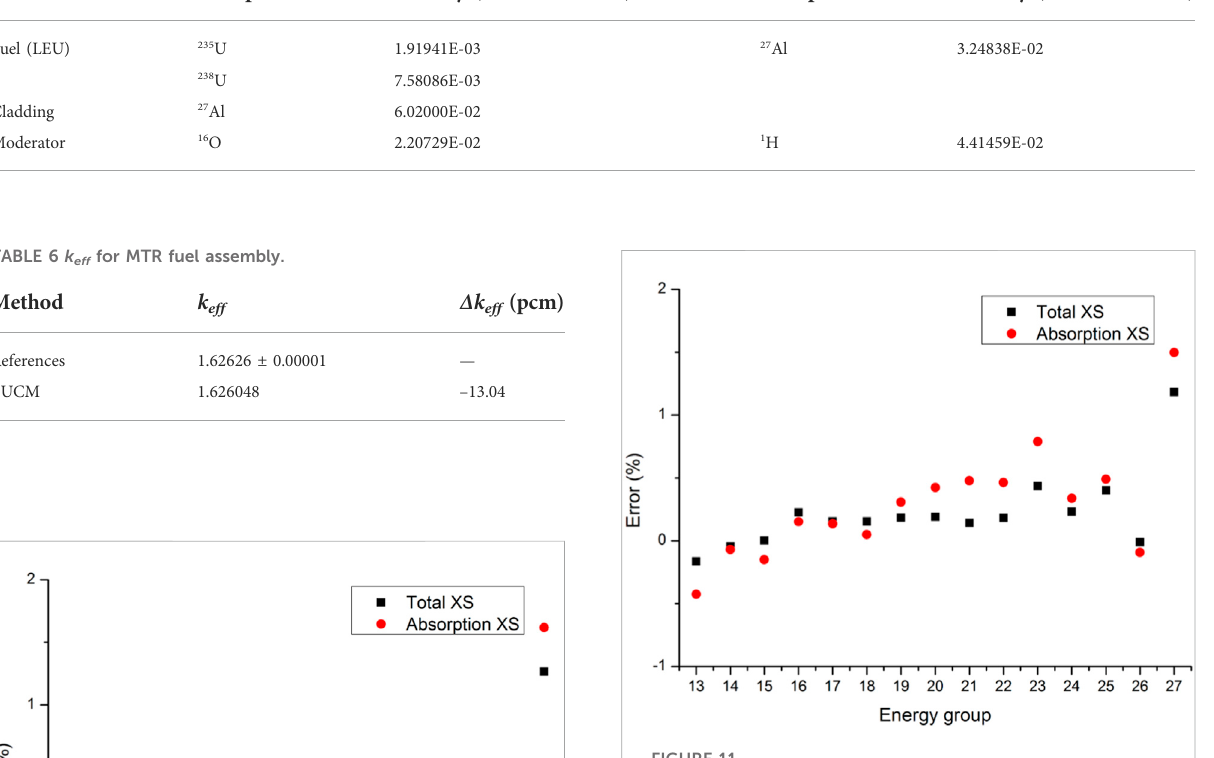
FIGURE 11 Comparison of 238 U total and absorption cross sections in Region 2.